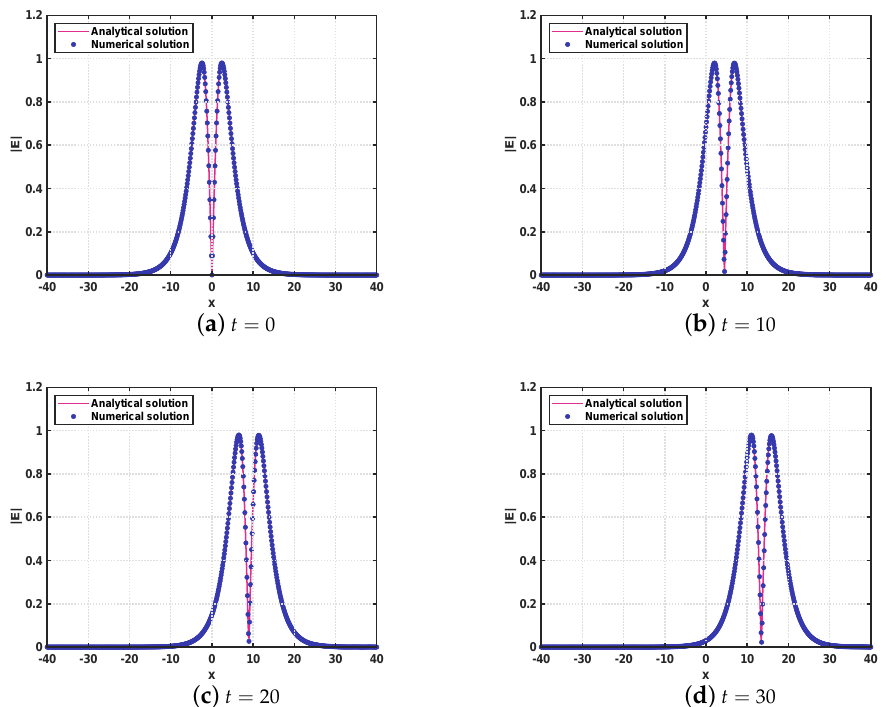
Figure 1. Comparison between numerical solution | E f | ( • ) and analytical solution | E | ( − ) with = 1 τ = τ C and h = 1 at different points in time for Case 1 of Example 2. 8 4 100